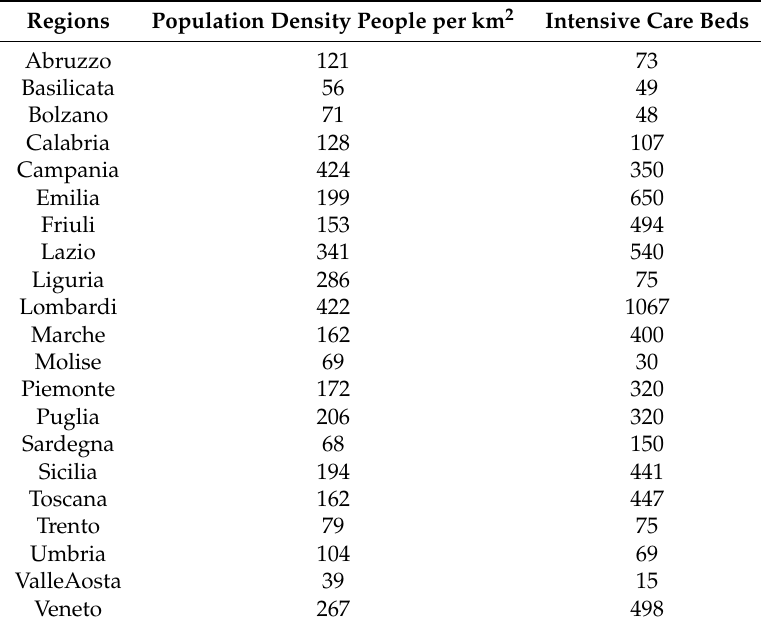
Table 2. Multiple linear regression